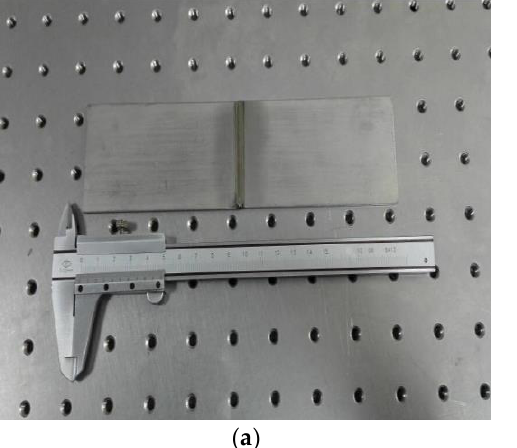
l is the measuring line; 0